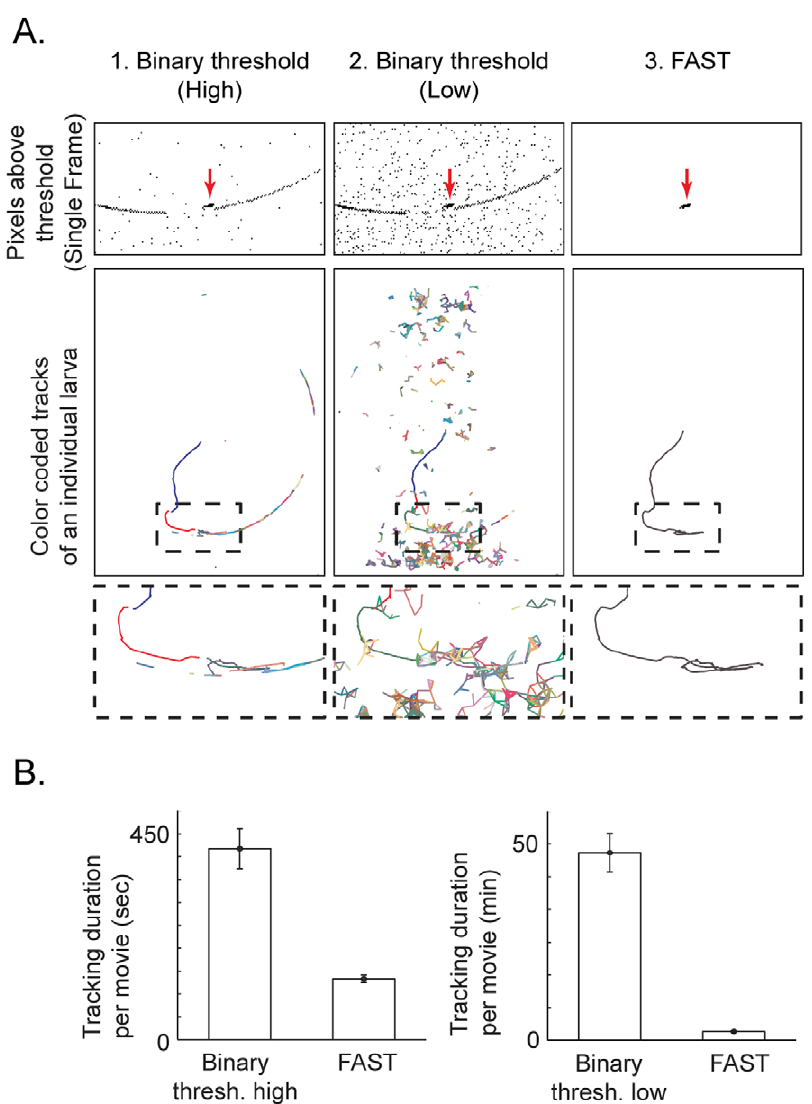
Figure 3. FAST allowed increased sensitivity for tracking. A. FAST was able to obtain the complete track of the larva. 1. With the binary threshold method, applying a high threshold (0.09) resulted in incomplete tracks as well as noise. 2. On the other hand, applying a low threshold (0.073) resulted in noise levels too high to reliably generate complete larval tracks. 3. In contrast, using FAST with a very low threshold (0.028) produced little noise and allowed for reliable generation of complete tracks. Top row: magnified view of a single movie frame showing pixels above threshold for each method. For visualization these pixels are represented as black pixels on white background. FAST was able to isolate the larva while eliminating other noise. Arrows indicate the larva. Middle row: tracks generated using each method. Each track segment of the larva is represented by a different color. Bottom row: magnified view of middle row. B. FAST was at least 3 times faster per movie than using binary threshold method with high threshold and 20 times faster than using low threshold (n=5).